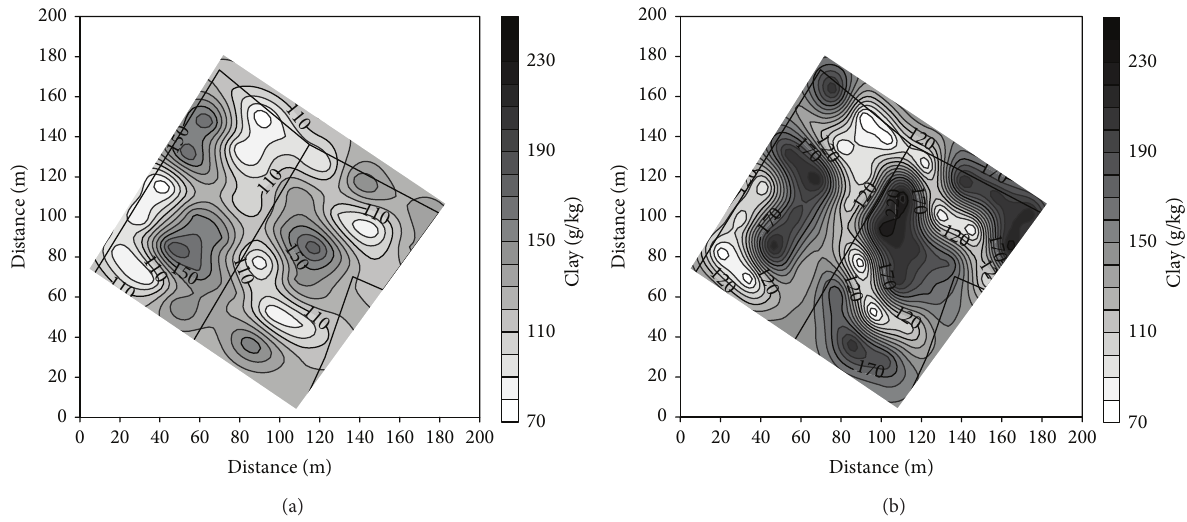
Figure 4: Distribution of clay (g kg −1 ) in the plowed layer (a) and subsoil (b).